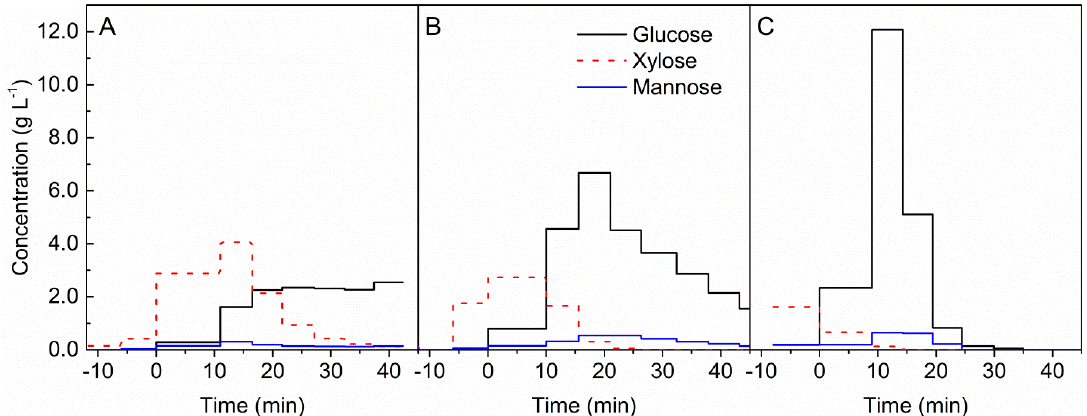
Figure 1. Formation of sugars during the hydrolysis of beech wood with 0.05 mol L − 1 sulphuric acid at different temperatures of ( A ) 180 °C, ( B ) 200 °C, and ( C ) 220 °C. t = 0 min marks the beginning of acid hydrolysis.